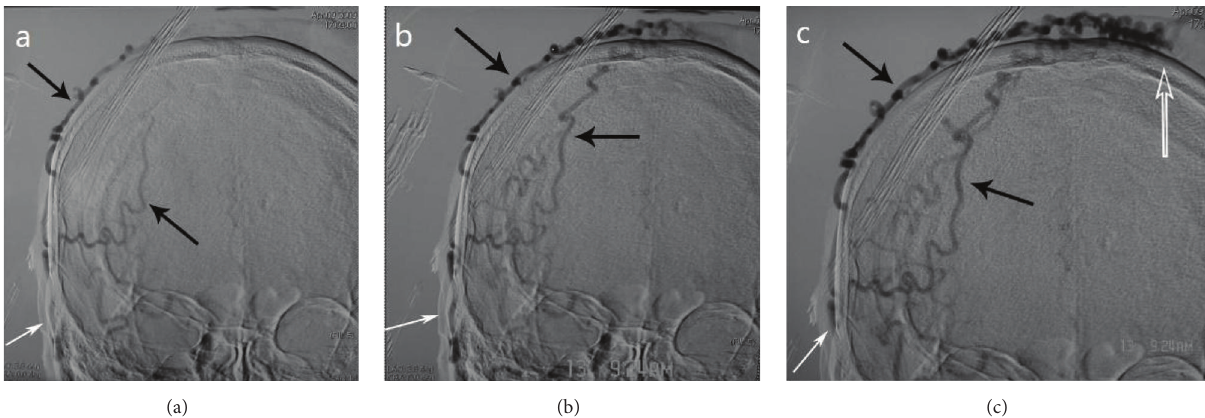
Figure 3: Digital subtraction angiography of the right ECA. (a) Anterior posterior projection, early imaging, white arrow shows the right STA; black arrow shows the tortuous branches of the right STA. ((b) and (c)) Anterior posterior projection, tortuous branches of the right STA supply the fistula; the hollow arrow indicates the point of the fistula. ECA: external carotid artery; STA: superficial temporal artery.